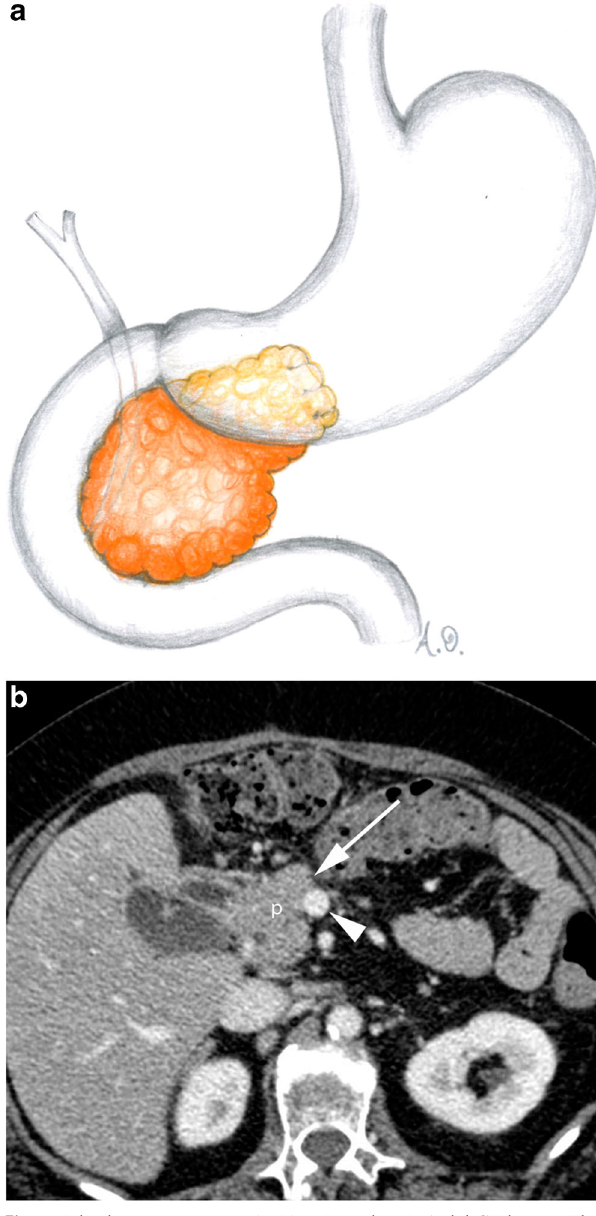
Fig. 3 Distal pancreatectomy ( a , b ). a Drawing. b Axial CT image. The head of the pancreas (p) is visible after a distal pancreatectomy. The resection margin (white arrow) is located at the level of the superior mesenteric vein (white